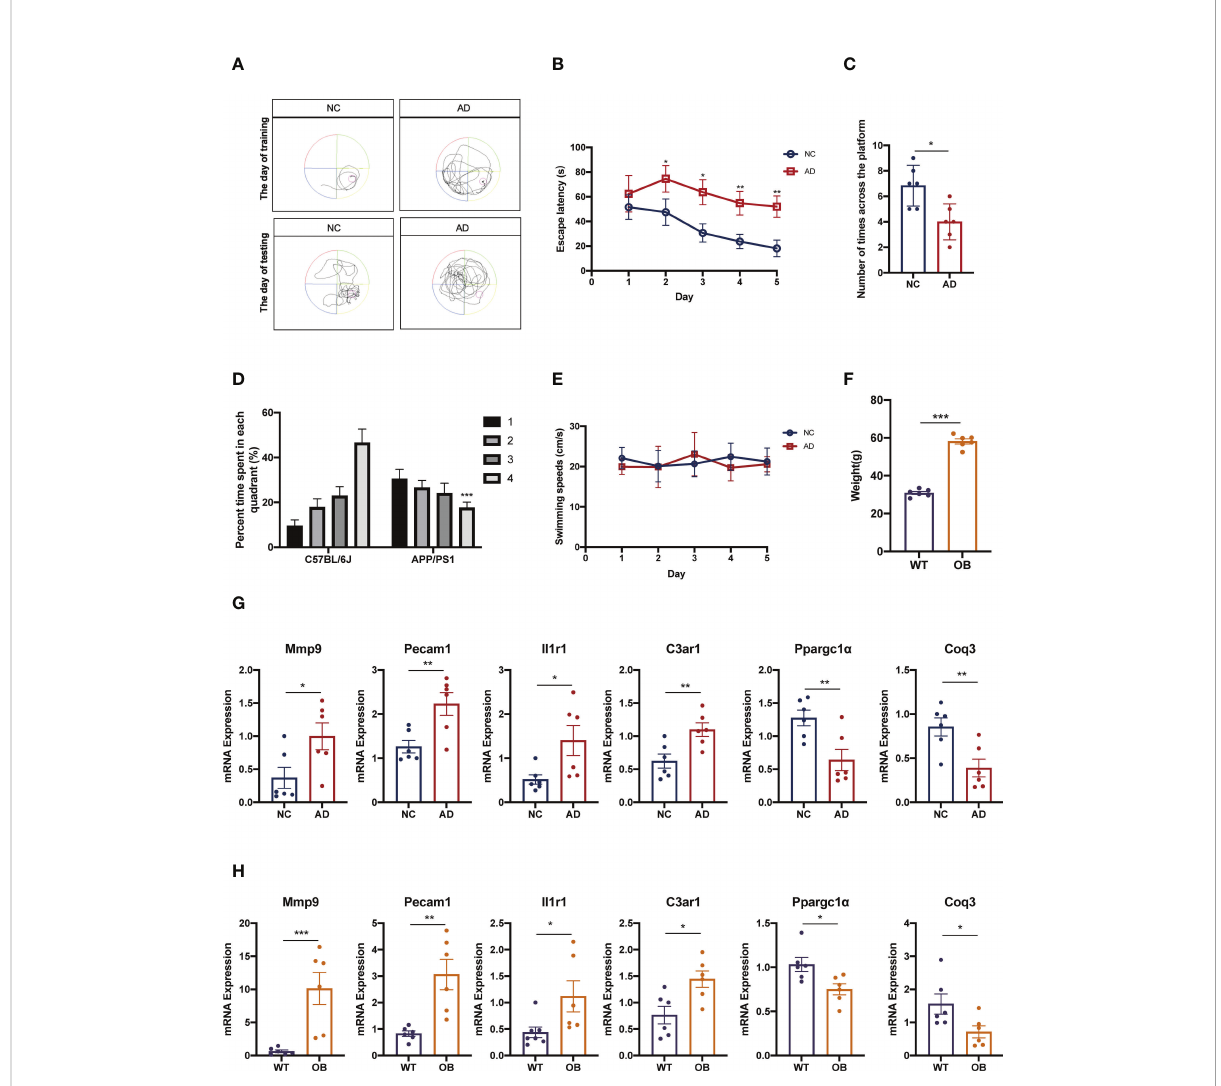
FIGURE 6 Con fi rmation of the different expression of candidate targets in animal models. (A – E) AD mice were subjected to hippocampal-dependent cognitive testing using the MWM. Data in (A, B) show the MWM training and data in (C, D) show the MWM testing. Data in (E) show mice swimming speeds. (F) Weight in in WT and OB mice. (G) The expressions of Mmp9, Pecam1, C3ar1, Il1r1, Ppargc1 a , and Coq3 were analyzed by qPCR analysis in cortex tissues from AD and NC mice. (H) The expressions of Mmp9, Pecam1, C3ar1, Il1r1, Ppargc1 a , and Coq3 were analyzed by qPCR analysis in subcutaneous adipose tissues from OB and WT mice. MWM, Morris water maze; WT, wild type; OB, obesity; NC, negative control; AD, Alzheimer ’ s disease. * p < 0.05, ** p < 0.01, *** p <